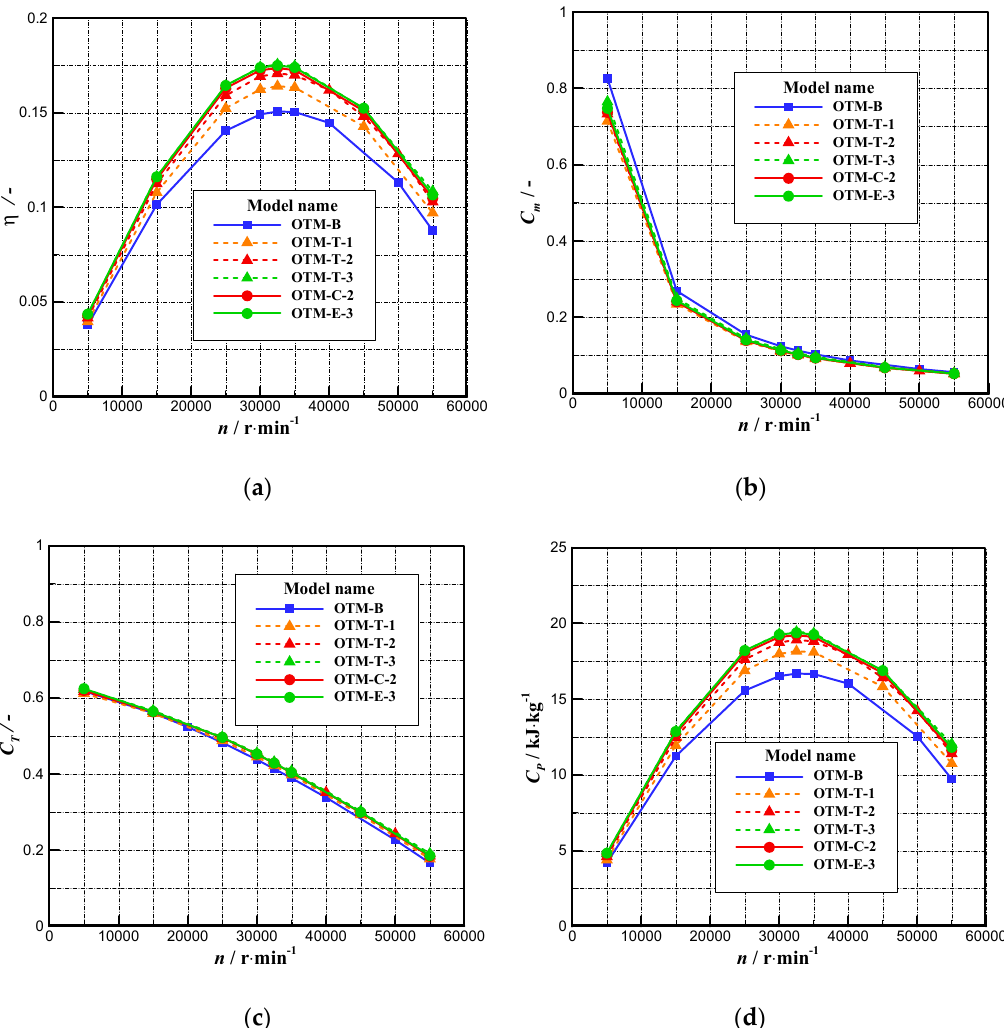
Figure 16. Aerodynamic performance versus the rotational speed for the one-to-many turbine models with different disc tips. ( a ) Isentropic efficiency; ( b ) flow coefficient; ( c ) torque coefficient; ( d ) specific power.